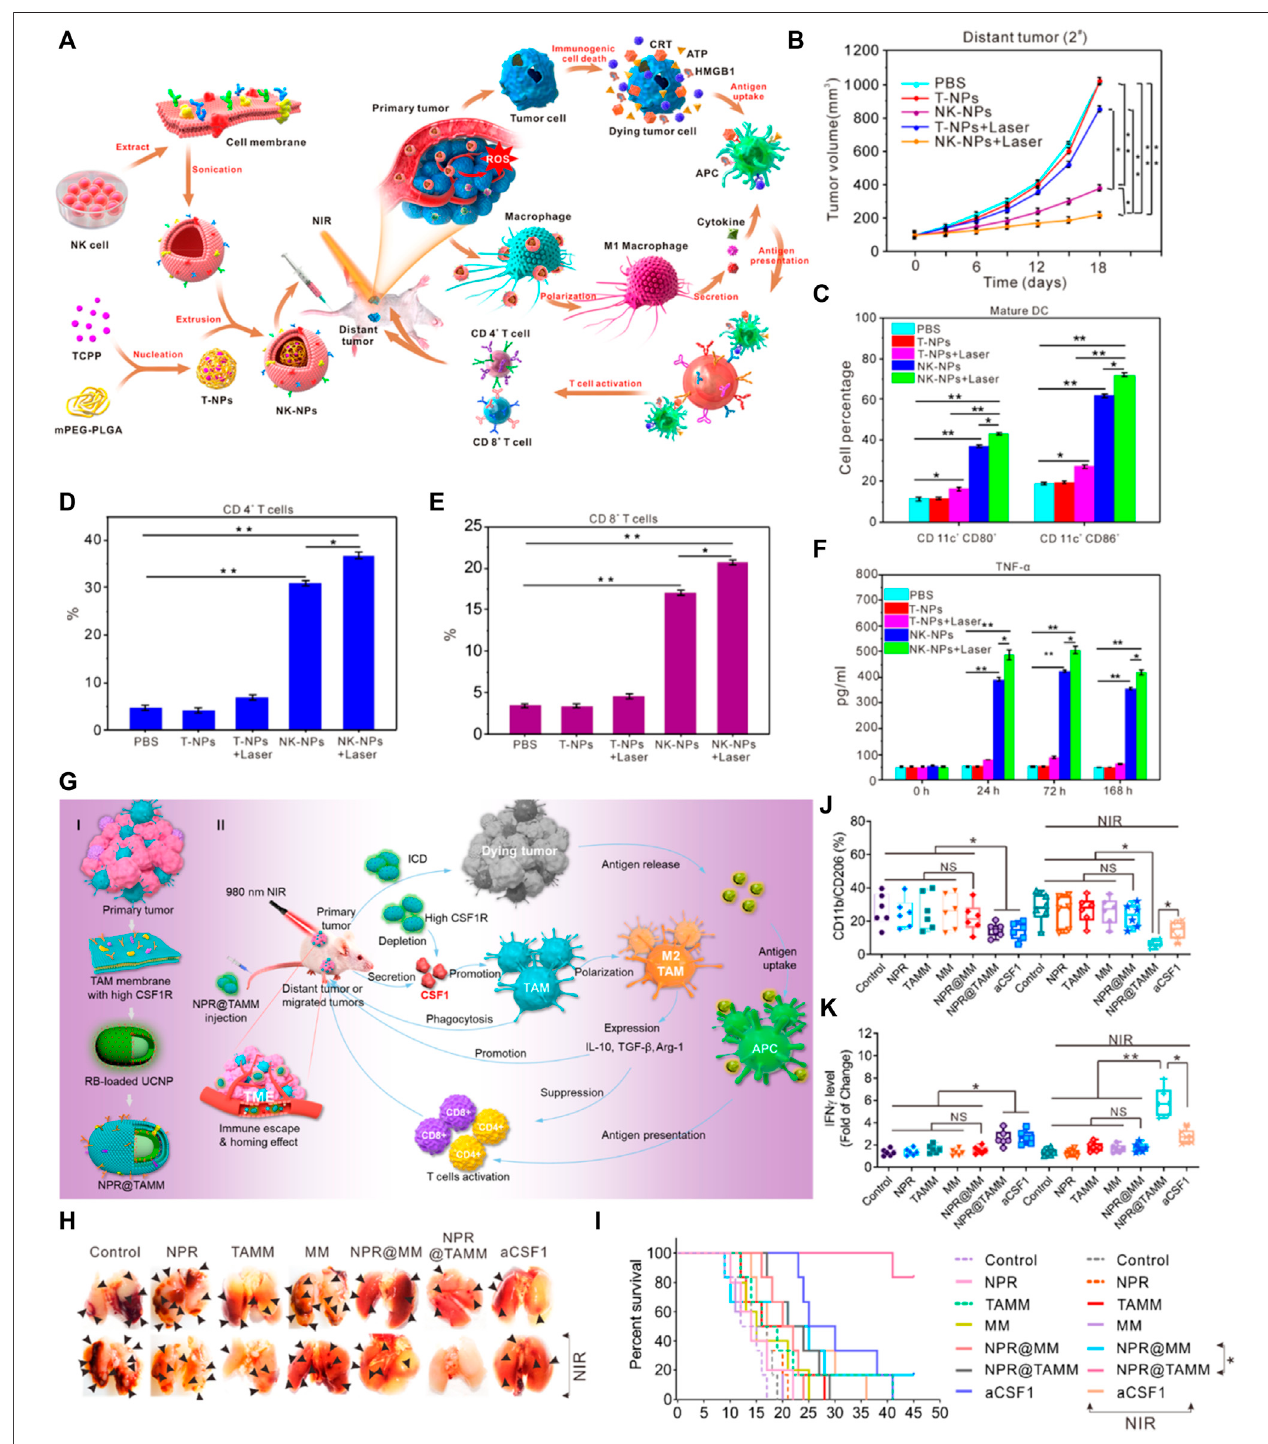
FIGURE 2 | Example of nanomedicine-based PDT to activate innate immune responses. (A) Schematic Illustration of NK Cell-Membranes-Cloaked Nanoparticles for PDT-Enhanced Cell-Membrane Immunotherapy. (B) Growth curves for the distal tumors. (C) In vivo maturation of DCs (CD80 + and CD86 + ) from tumor-draining lymph nodes in BALB/c mice following intravenous injection of T-NPs or murine NK-NPs ( n = 3 per group). (D) Proportions of tumor-in fi ltrating CD4 + T cells. (E) Proportionsoftumor-in fi ltratingCD8 + Tcells. (F) Pro-in fl ammatorycytokines(TNF- α )levelsintheseraofmicetreatedwithmurineNK-NPs-mediatedPDTfromday 0, day 1, day 3, and day 7 (Deng et al., 2018). (G) Schematic illustration of the tumor-associated-macrophage-membrane-coated upconversion nanoparticles for improved photodynamic immunotherapy. (H) Photographs show representative external views of lung nodules. (I) The survival curve of tumor-bearing mice calculated